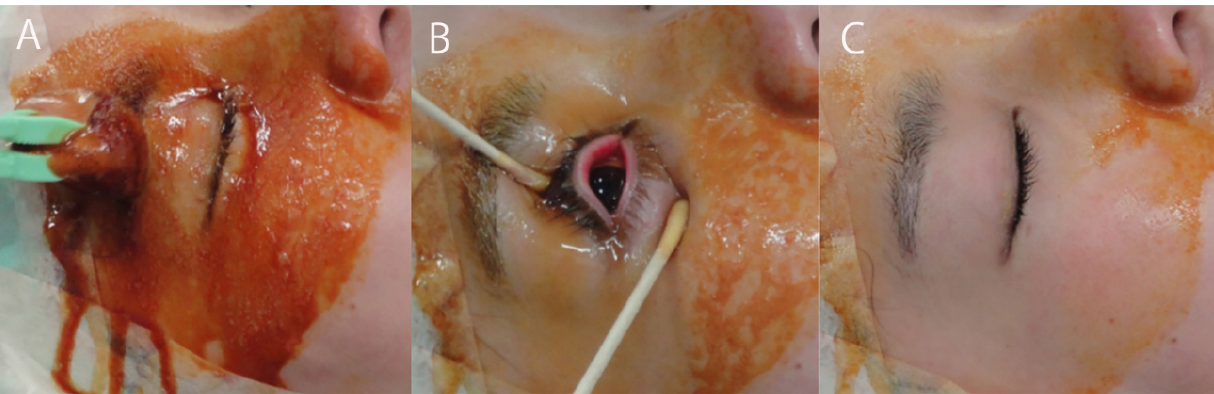
Figure 9. Preoperative cleaning of the eyelid skin. ( A ) Disinfect the skin around the eye with 10% povidone-iodine. ( B ) Disinfect the ocular surface with 0.25% povidone-iodine. To maintain the bactericidal effect, do not rinse off the 0.25% povidone-iodine with saline. ( C ) Wipe off the 10% povidone-iodine around the eye, but leave the peripheral povidone-iodine which helps to identify the eye to be operated on. (Modified from [69]).